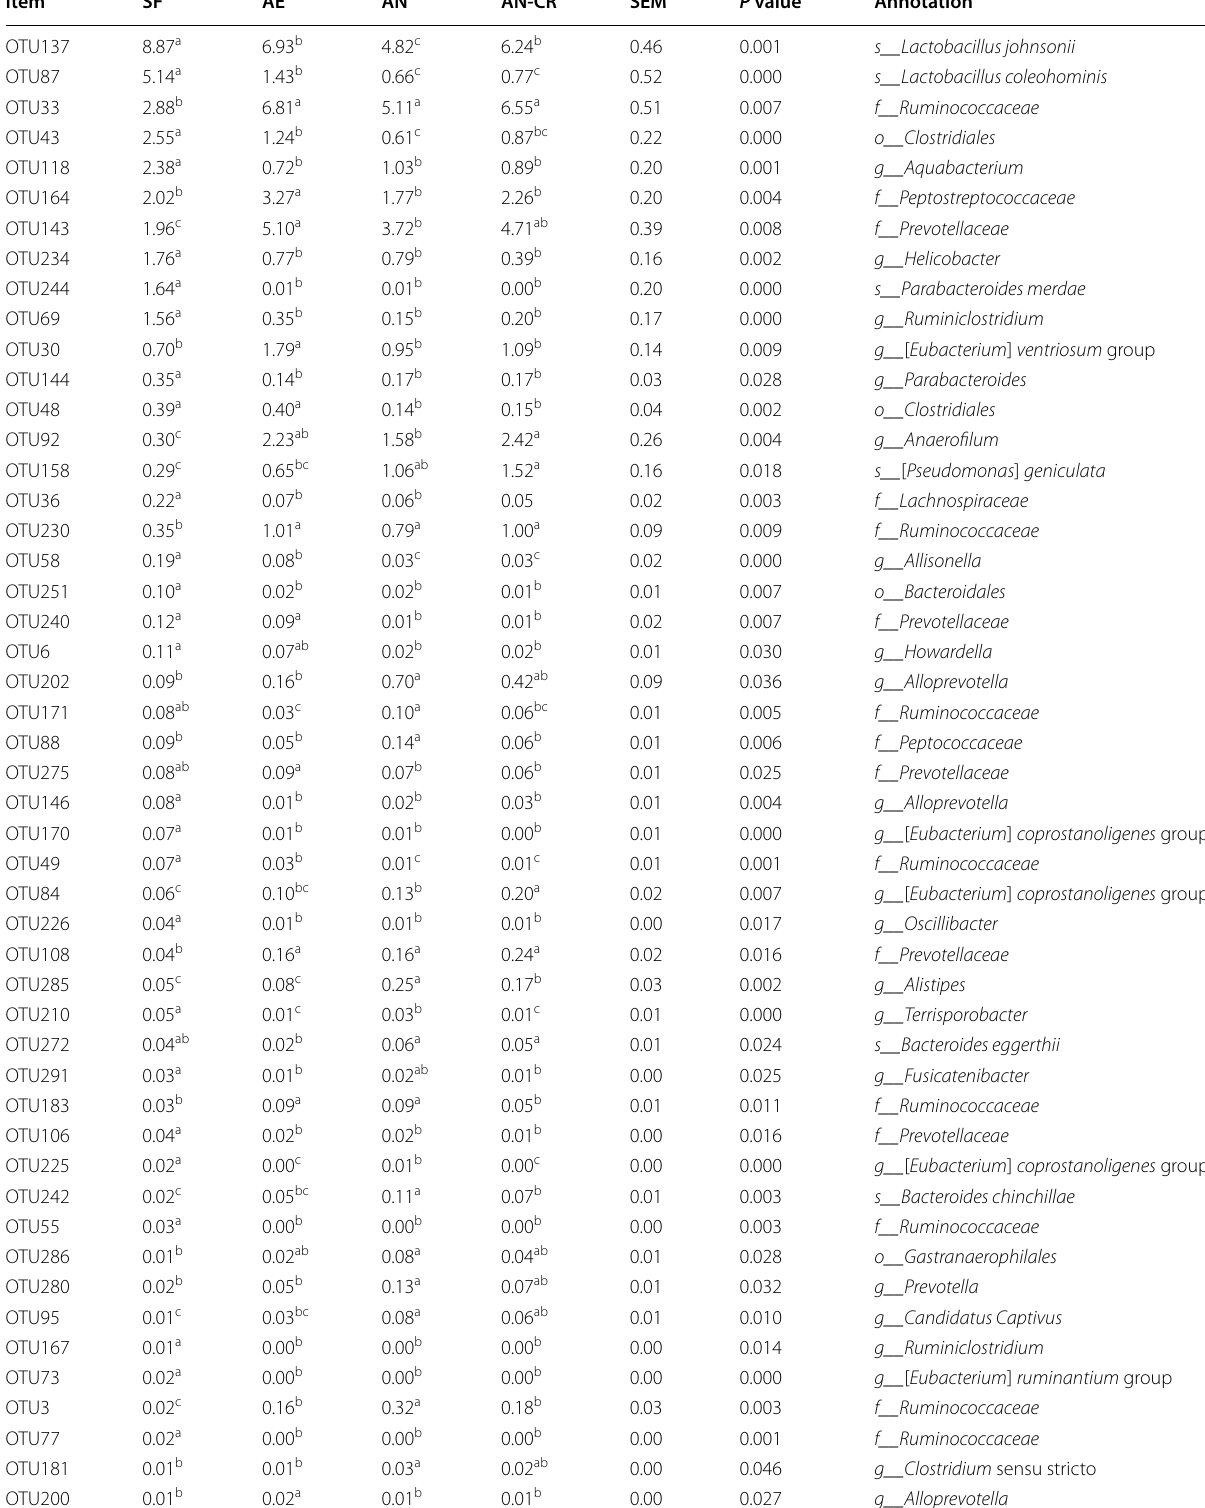
Table 3 Relative abundances of active microbial OTUs that were significant different among all